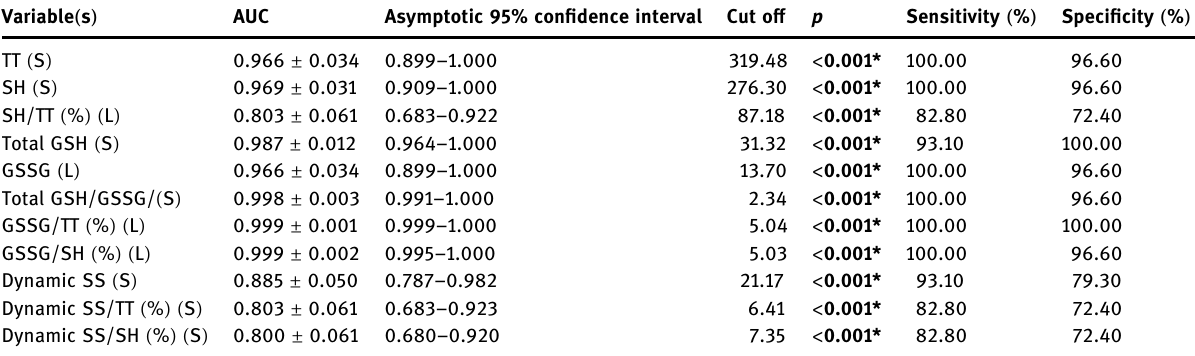
Table 4: ROC analysis of variables in patient and control groups Variable ( s ) AUC